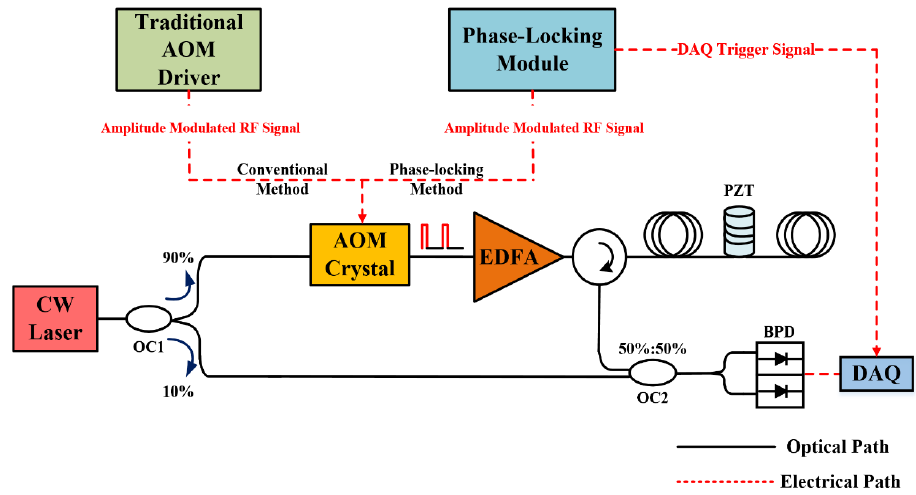
Figure 5. Experimental setup: CW Laser: continuous wave laser; AOM: acoustic optical modulator; EDFA: erbium-doped fiber amplifier; OC: optical coupler; BPD: balanced photo detector; DAQ: data acquisition card; PZT: piezoelectric trans- ducer.